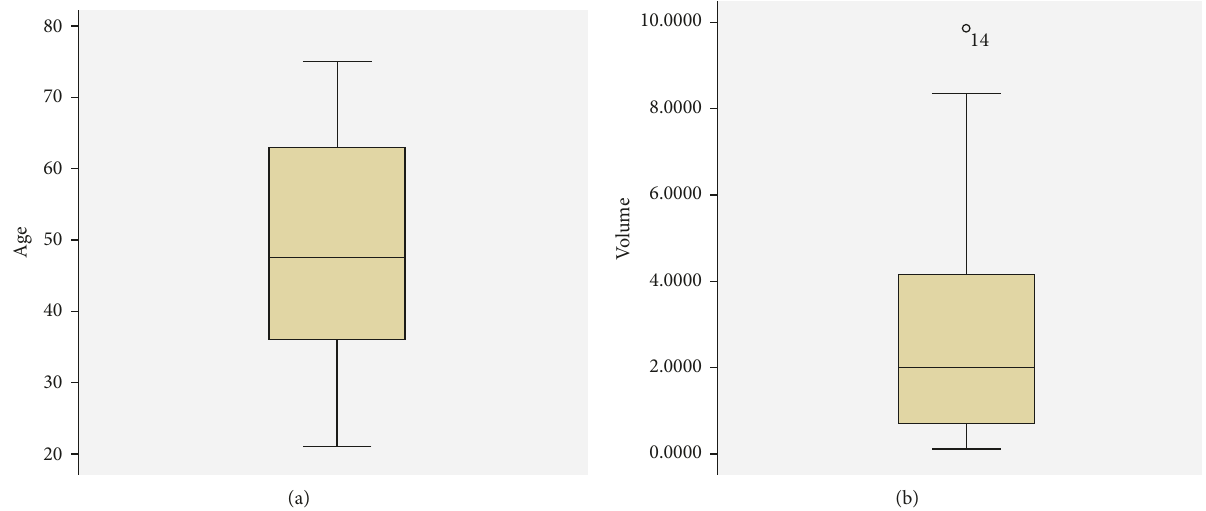
Figure 5: (a) Box plot diagram showing the median age of patients appearing with adrenal pseudocysts. (b) Box plot diagram of the mean volume of the mass in patients with adrenal